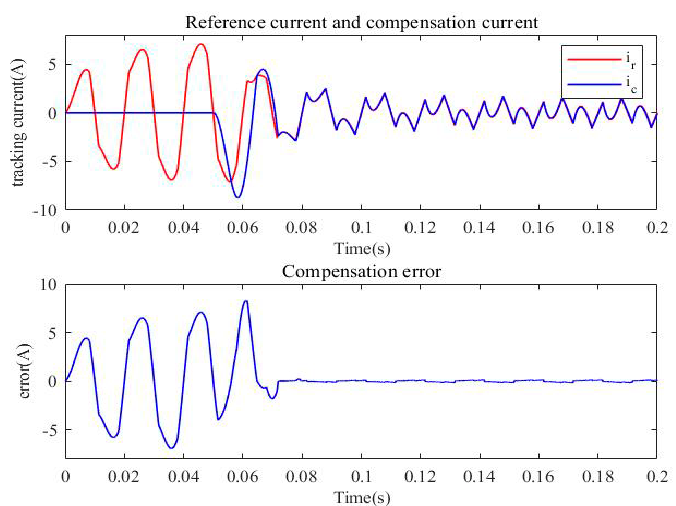
Figure 8. Current tracking and error waveforms of steady − state response using ASMC-NFNN from top to bottom: current tracking and tracking error curve.